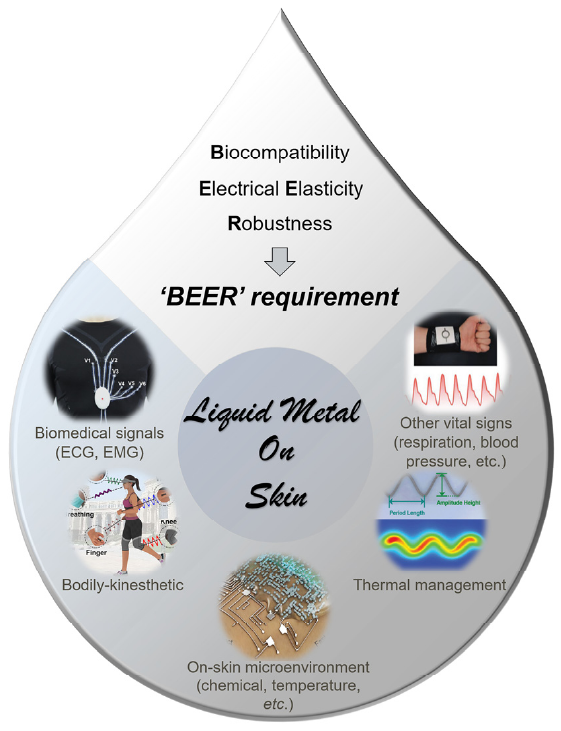
Figure 1. The ‘ BEER ’ requirement for flexible electronics for on-skin healthcare and the extensive applications of LM-based electronics in on-skin biomedical signals collection, on-skin microenvironment monitoring, bodily-kinesthetic recognition, thermal management, and other vital signs.